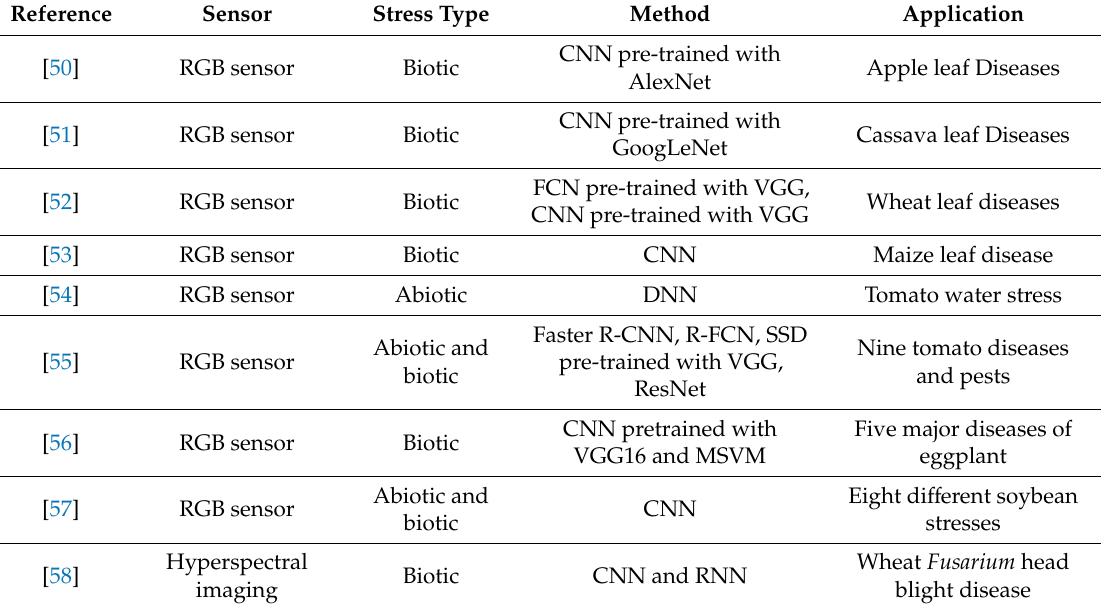
Figure 4. Applications of deep learning for crop stress detection based on di ff erent image analysis. ( a ) Classification (images from [47]), ( b ) segmentation (images from [48]), and ( c ) object detection (images from [49]). Table 1. Applications of deep learning for crop stress